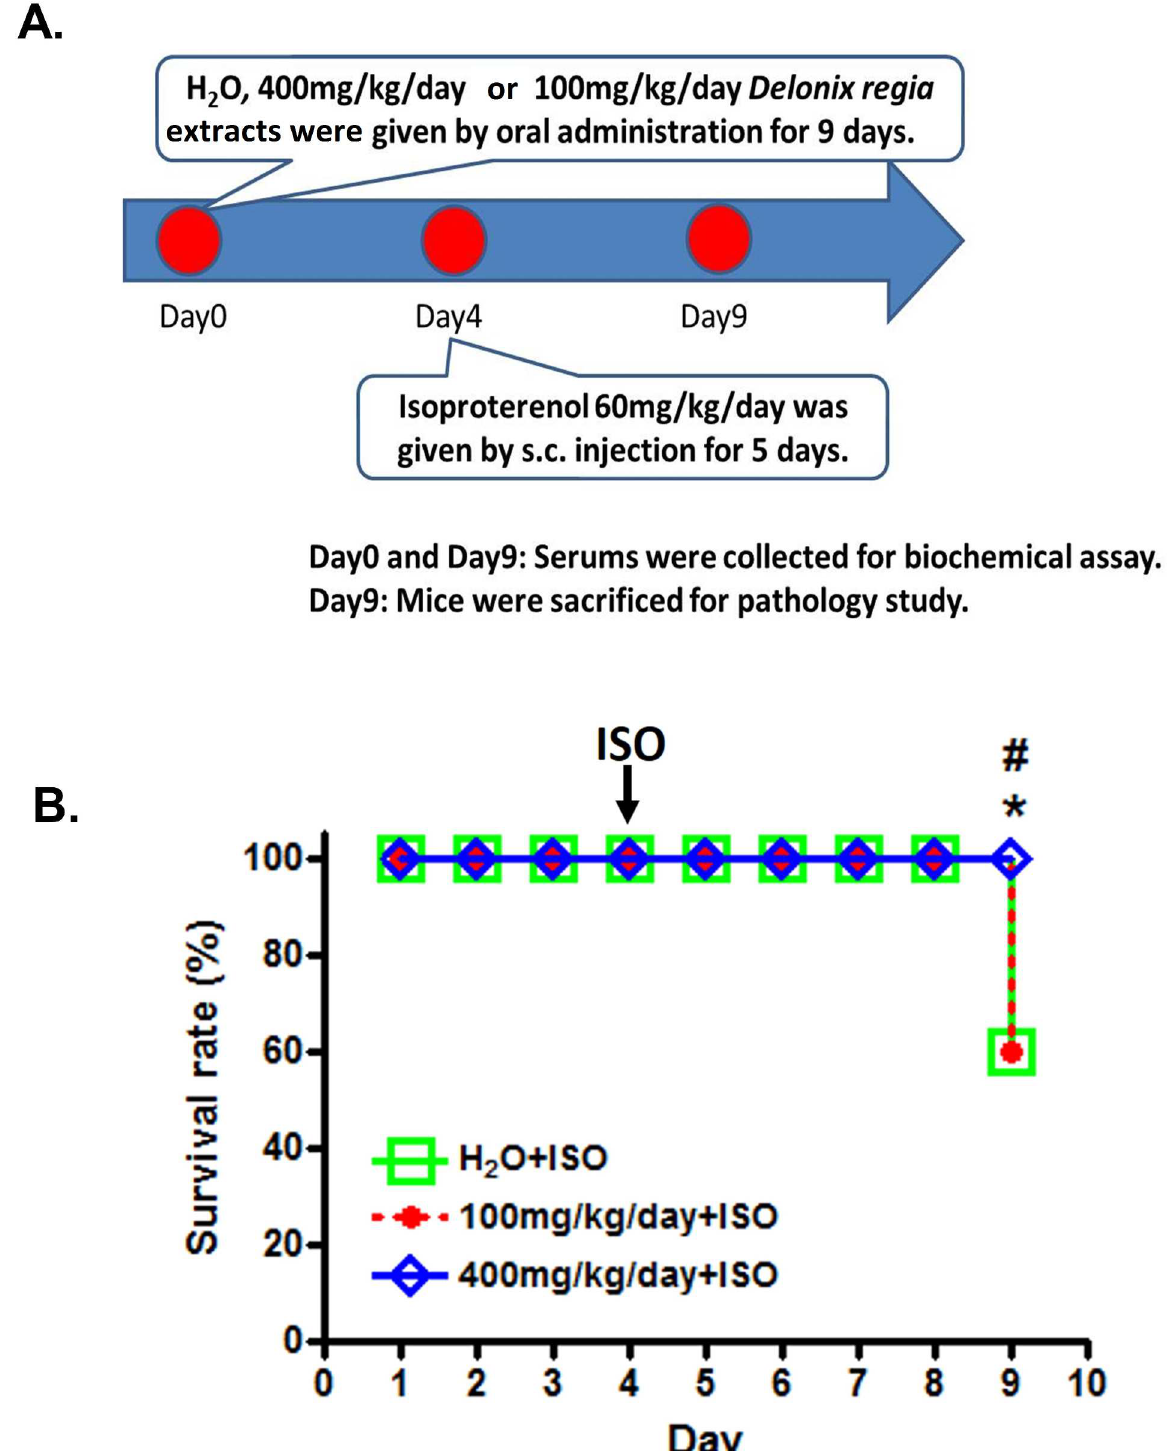
Fig 1. DRLE had a cardioprotective effect. (A) H 2 O and DRLE (100 mg/kg/d) and (400 mg/kg/d) were orally administered to C57BL/ 6 mice for 9 d. At Day 4, 60 mg/kg/d of isoproterenol was injected subcutaneously for 5 d. (B) The survival rate of ISO-injectedmice treated with H 2 O and 100 mg/kg/d and 400 mg/kg/d of DRLE. * , P < 0.05 vs. H 2 O. # , P < 0.05 vs. 100 mg/kg/d (n = 5 per group).